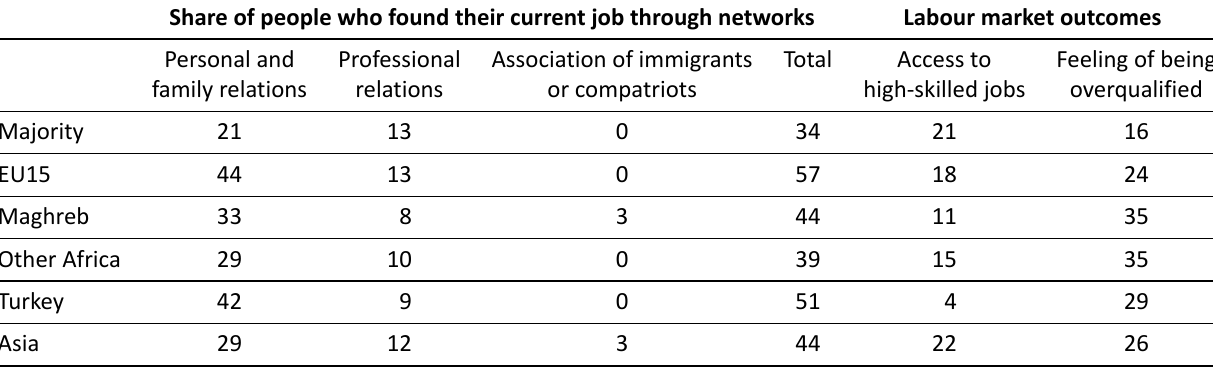
Table A3. Labour market outcomes for immigrants and the majority population in 2014 (in %). Source: adhoc module